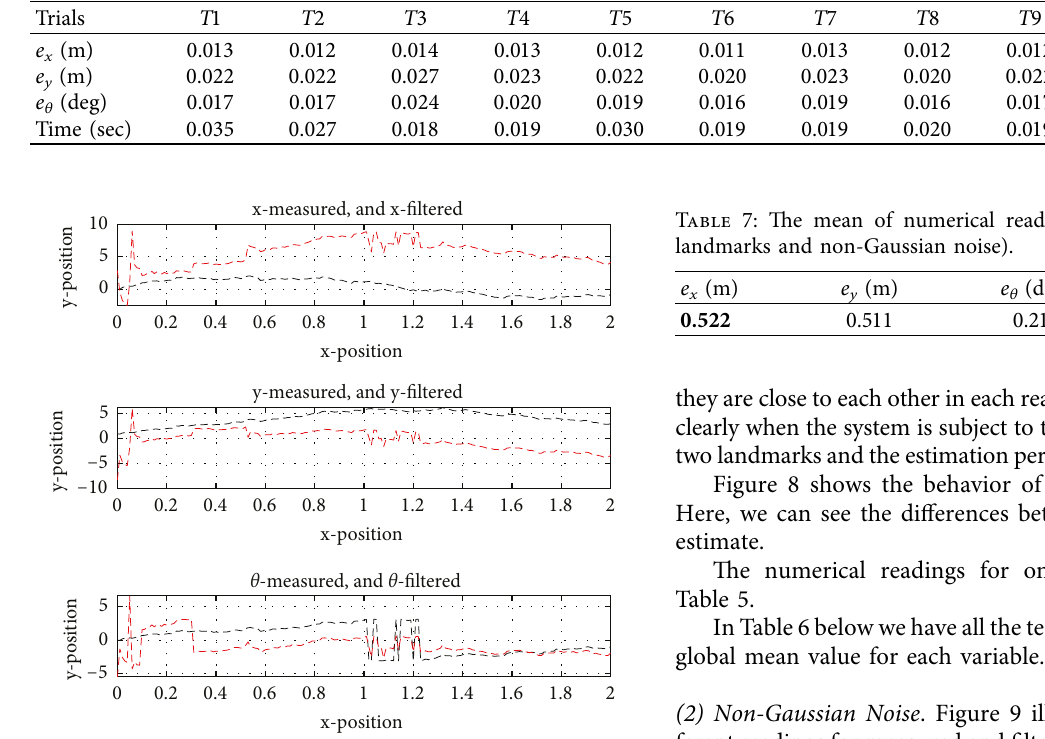
Table 6: The mean of trials with the EKF (two landmarks and Gaussian noise).